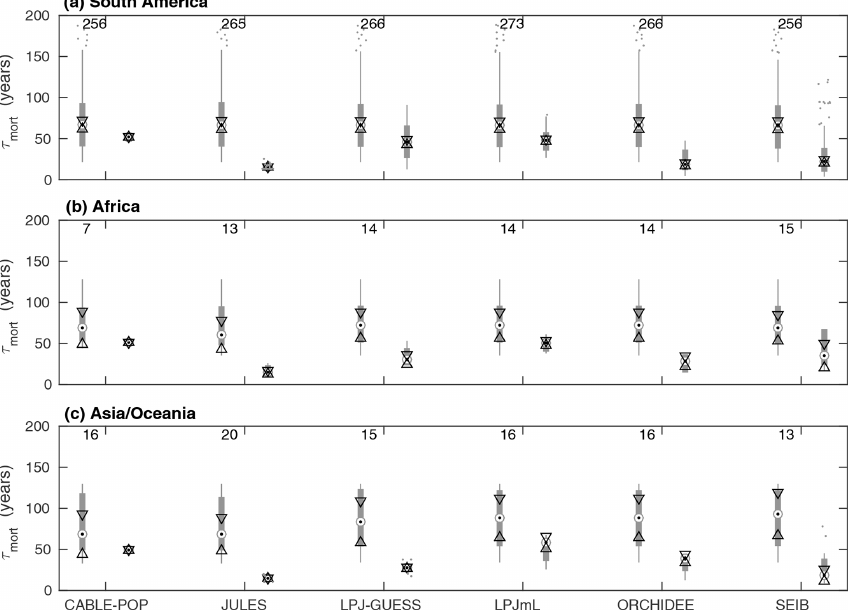
Figure 6. Comparison of τ mort from observations at forest plots across the tropics against modelled values of τ mort obtained for the same sites. For each model, box plots on the left show the observations and on the right the model results. Observations are shown separately for each model because some sites were not simulated as forest by some of the models. The number of sites included in the comparison is shown above the bars. Circles with dots show the median, with triangles identifying its 95% confidence limits. Thick grey bars show the interquartile range, with thin grey bars extending to the 10th and 90th percentiles. Outliers are marked with dots (horizontal spread illustrative only). The y axis is truncated at 200 years.